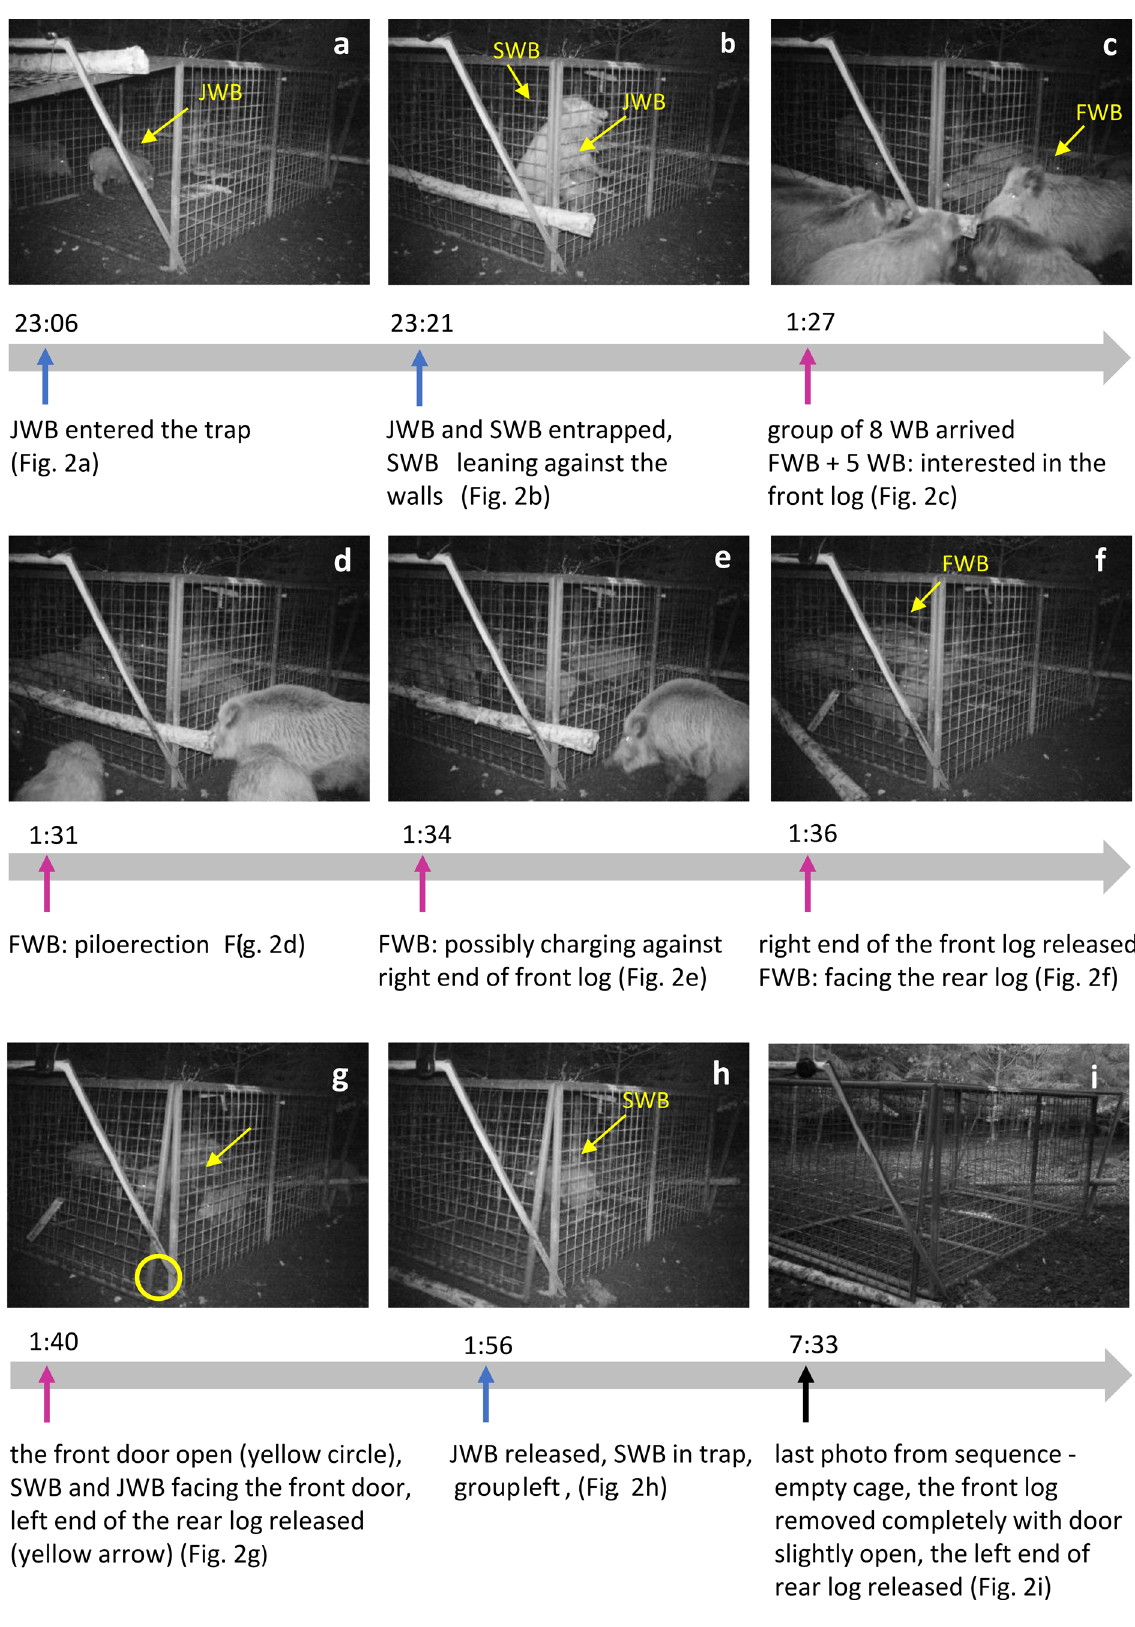
Figure 2. Timeline and photos documenting the potential rescue event by wild boar. Victims: SWB = subadult wild boar, JWB = juvenile wild boar; rescuer: FWB = female wild boar. The behaviour of the potential rescuer is indicated by pink arrows and the behaviour of victims by blue arrows in the